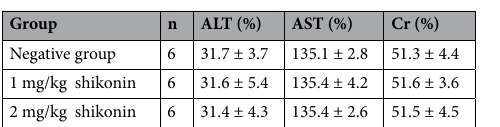
Table 1. The effect on liver and kidney toxicity in